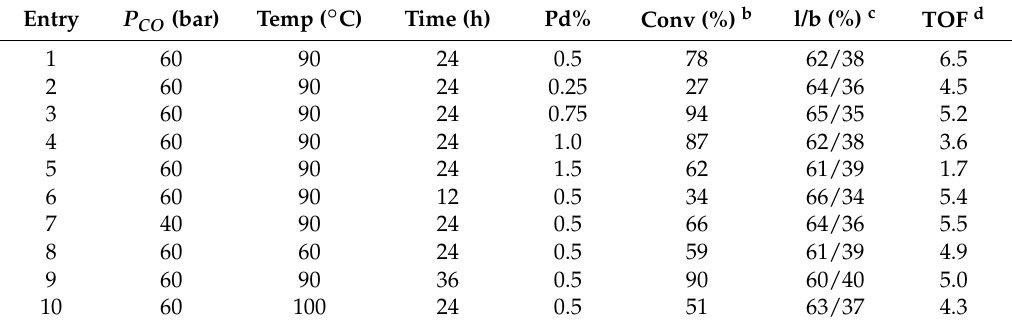
Table 2. The effect of the reaction conditions in the methoxycarbonylation of 1-hexene using complex 2 a